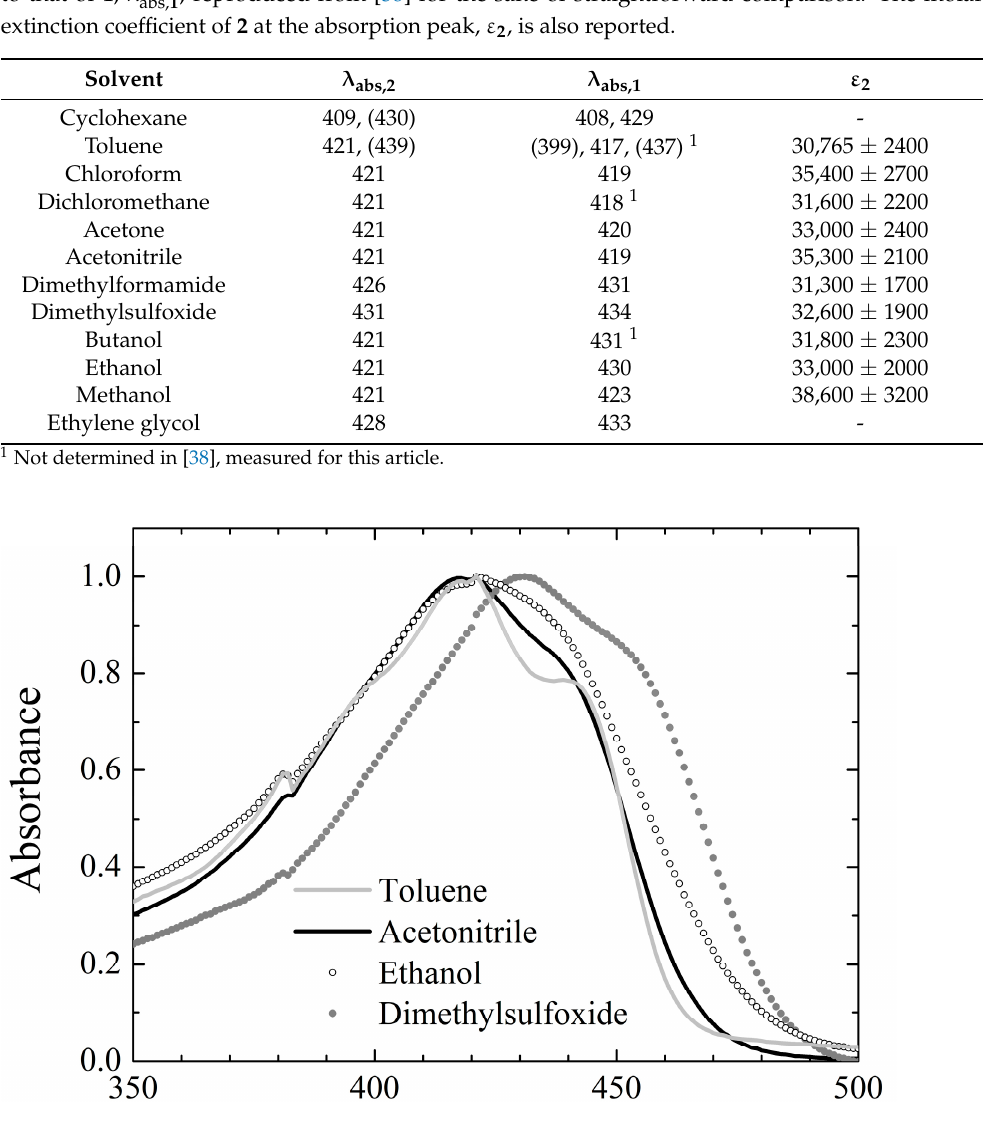
, is compared abs, 2